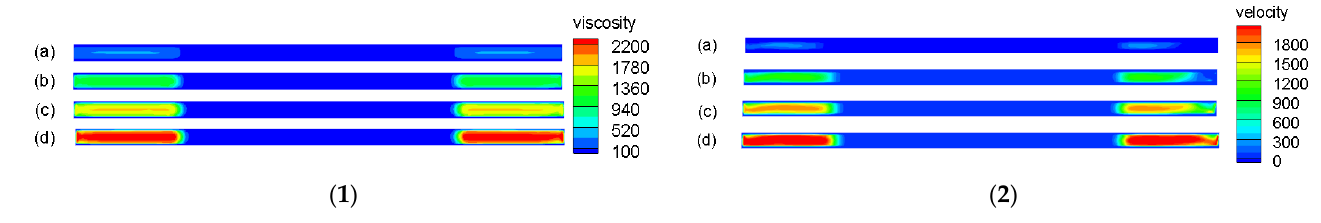
Figure 11. The viscosity distribution in the damping channel when the current is 0.5 A, 1 A, 1.5 A and 2 A at different velocities. ( 1 ) velocity = 0.1 m/s.; ( 2 ) velocity = 0.5 m/s. (a) the current is 0.5 A; (b) the current is 1 A; (c) the current is 1.5 A; (d) the current is 2